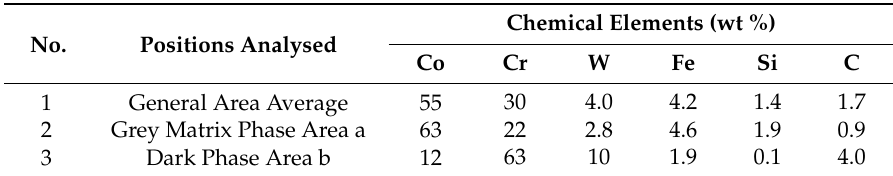
Table 5. Compositions of different areas in the produced bushing coatings by energy dispersive spectrometer (EDS).